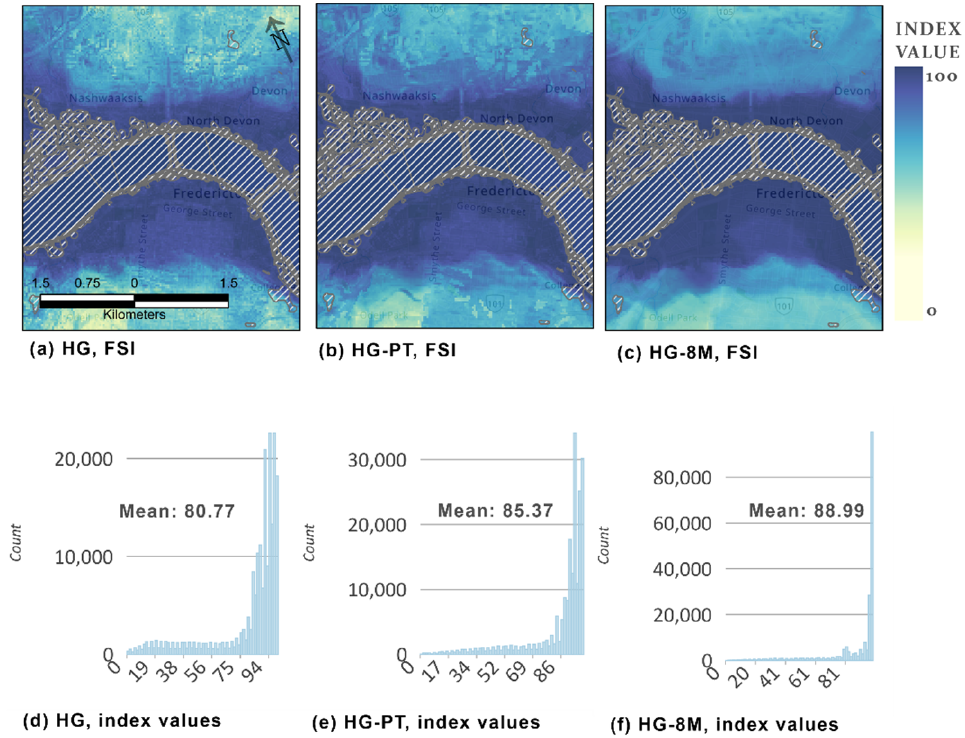
Figure 8. Distribution of Index pixel values within the boundaries of the Canadian Historic flood event polygon (dissolved polygon of all events on record) from the parRF model.